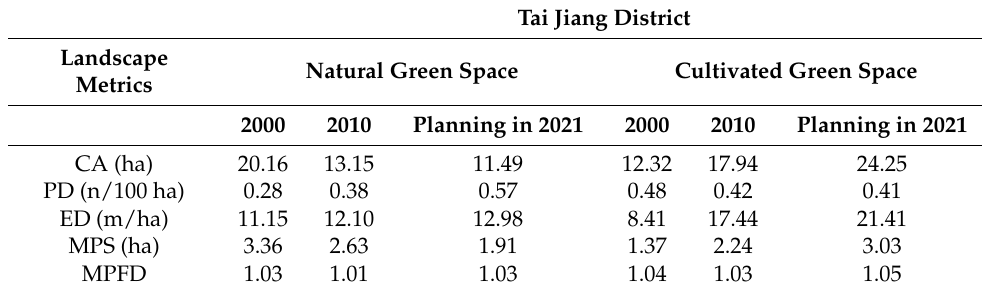
Table A4. The comparison of landscape metrics on class level of Tai Jiang district.